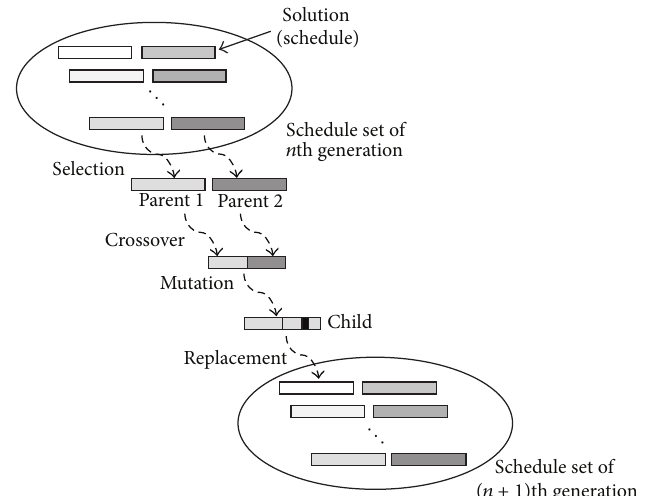
Figure 5: Each step of a genetic algorithm to perform electricity usage scheduling.